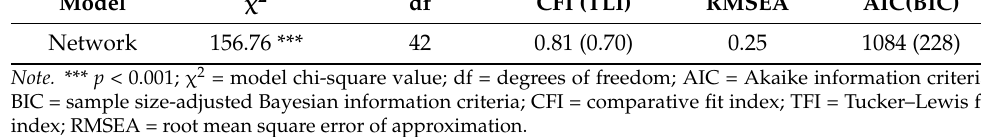
Table 4. Model fit indices for network model of post-test measures.